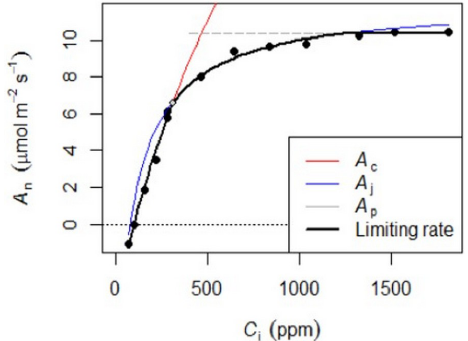
Figure 4. Example of the A n - C i response. Net photosynthesis ( A n ) at any given C i is the minimum of three potential limitations: ru- bisco (A c ), RuBp (A j ), or TPU (A p